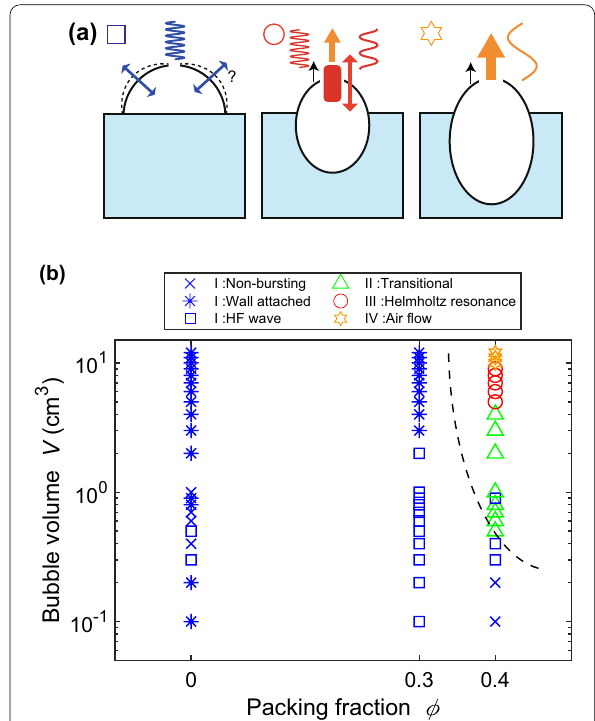
Fig. 4 a Schematic diagram showing the 3 main styles of bubble bursting and airwave excitation. Left : a hemispherical cap bubble sits at the surface and bursts, exciting a high-frequency (HF) wave. A “?” indicates that the modes are unknown. Middle : a bubble bursts while it is rising and excites Helmholtz resonance (mostly with HF wave component), and later vents an air flow. Right : a bubble bursts while it is rising and vents an air flow. b A regime diagram in the parameter space of suspension φ and bubble volume V . A broken curve indicates the main regime boundary (see text for